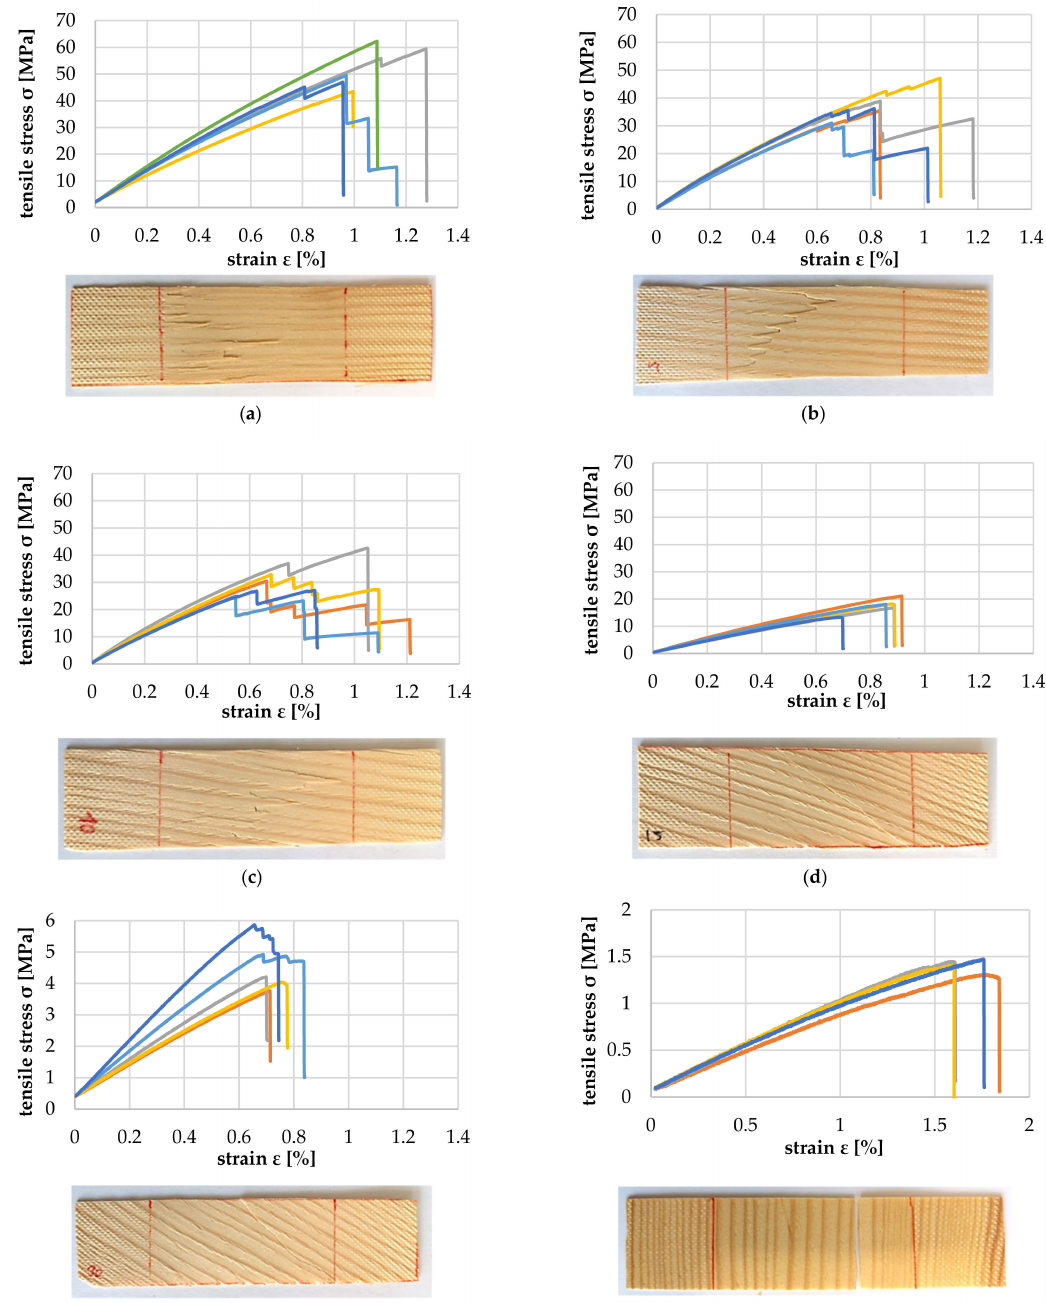
Figure 18. Tensile test at 0 ◦ ( a ), 5 ◦ ( b ), 10 ◦ ( c ), 15 ◦ ( d ), 30 ◦ ( e ) and 90 ◦ ( f ) deviation between particle and tracheid longitudinal